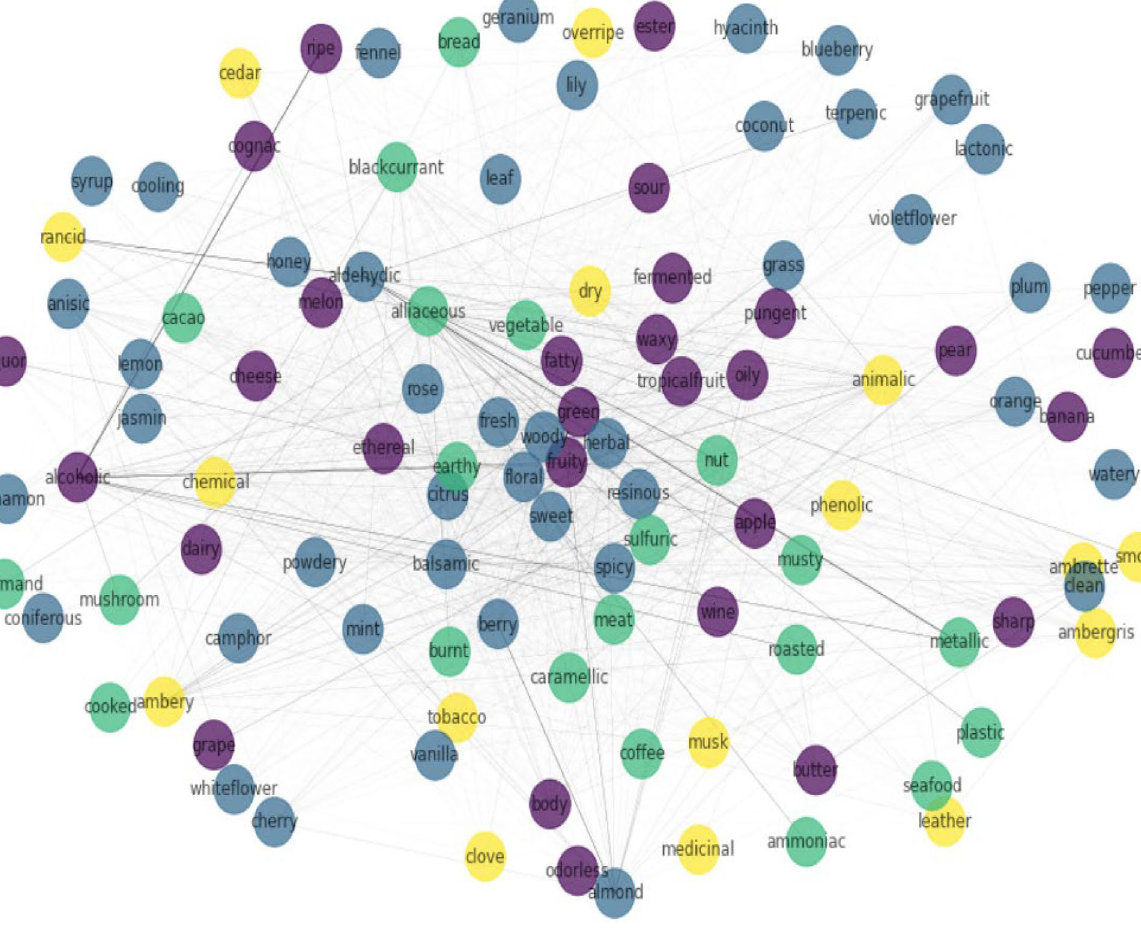
Figure 8. Graph constructed on the basis of Louvain method for community detection in networks. Nodes with the same colour belong to the same